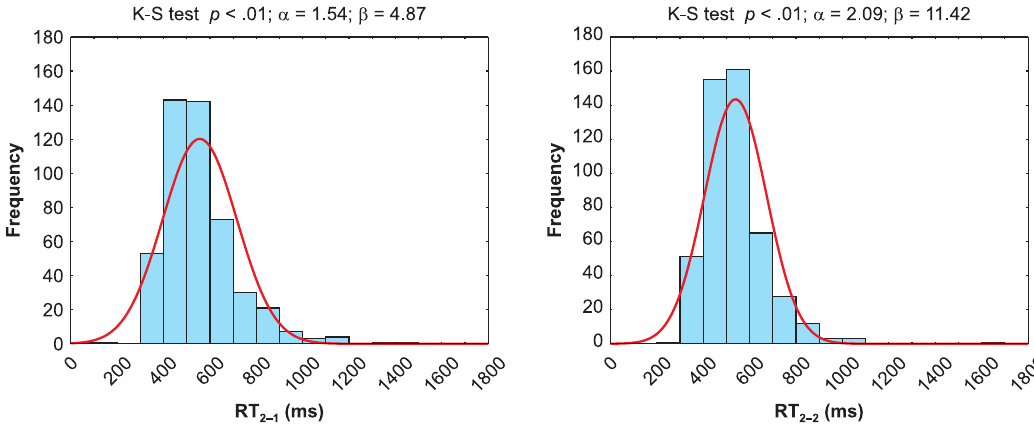
, RT = reaction 1–1 1–2